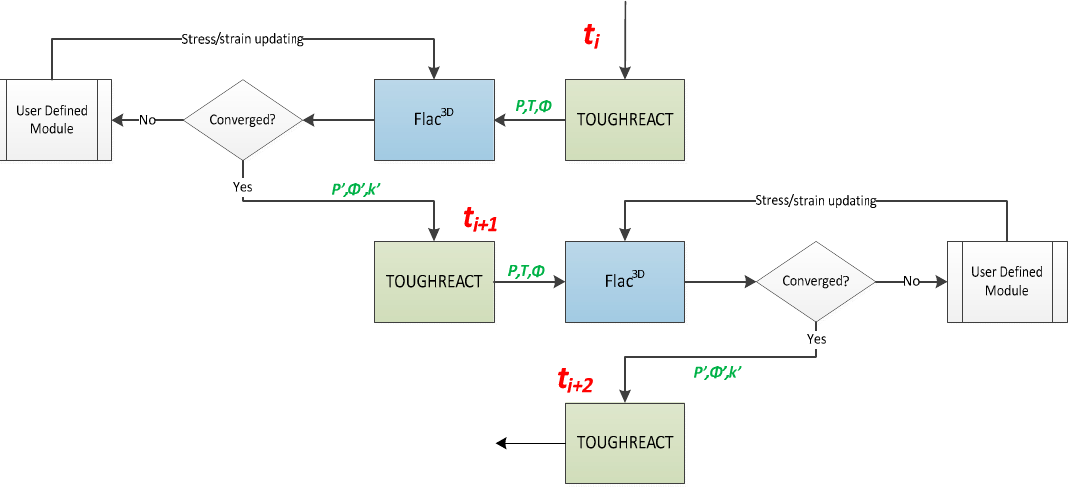
Figure 4. Schematic diagram of algorithmic and data exchange between FLAC3D DM and TOUGHREACT.